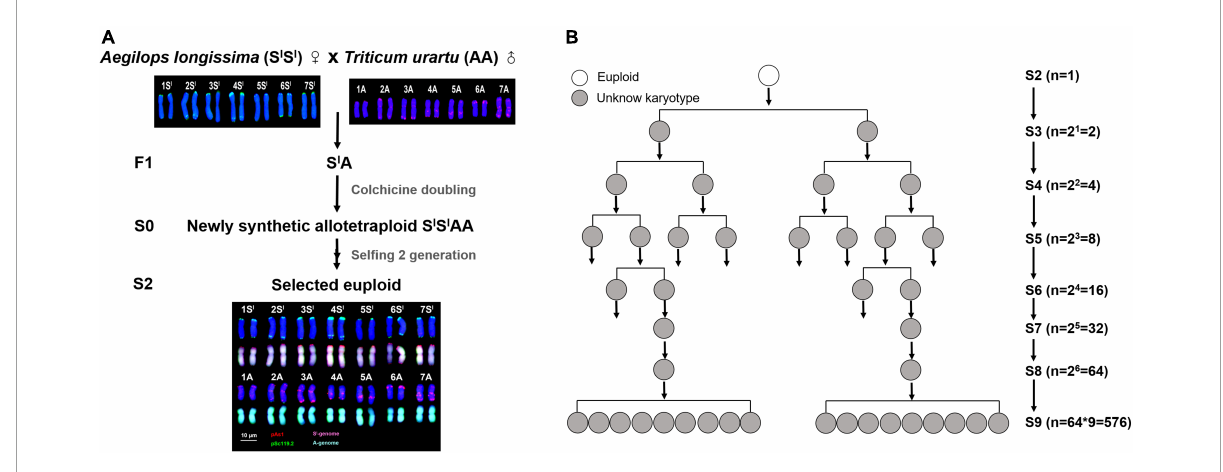
FIGURE1 The standard karyotypes and pedigree tracing of a lineage with high degree of chromosomal instability in a synthetic allotetraploid wheat (S l S l AA). (A) The FISH/GISH-based standard karyotypes of S l S l AA and its diploid parents. (B) Pedigree of the chromosomal unstable lineage containing a total of 576 individuals at S9, which were descended from the single euploid founder plant of S2. The pAs1 (red) and pSc119.2 (green) clones were used as FISH probes. The genomic DNAs of Ae. longissima (S l S l , red) and T. urartu (AA, green) were used as GISH probes.